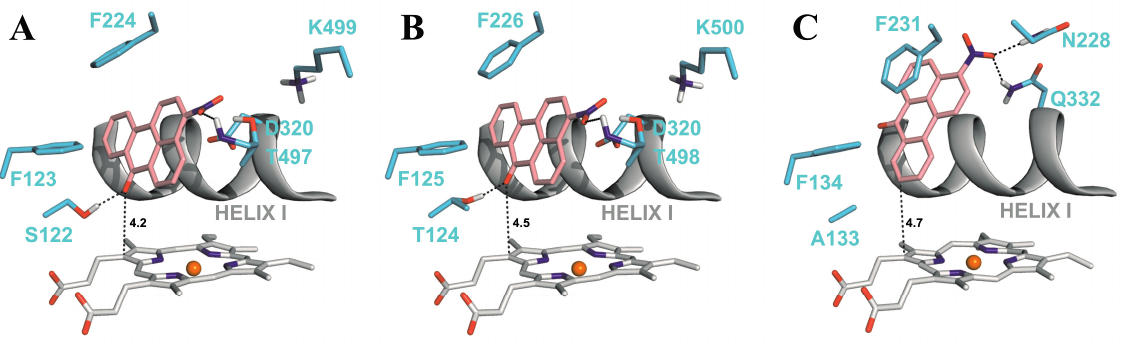
Figure 6. The most favorable binding orientations of 3-NBA docked into the active site of CYP1A1 ( A ), 1A2 ( B ) and 1B1 ( C ). Hydrogen bonds between 3-NBA and the amino acid residues in active site residues are rendered as dashed black lines. 3-NBA (pink), heme (grey) and side chains of important amino acid residues (cyan) are rendered as bold sticks; iron ions as orange spheres.